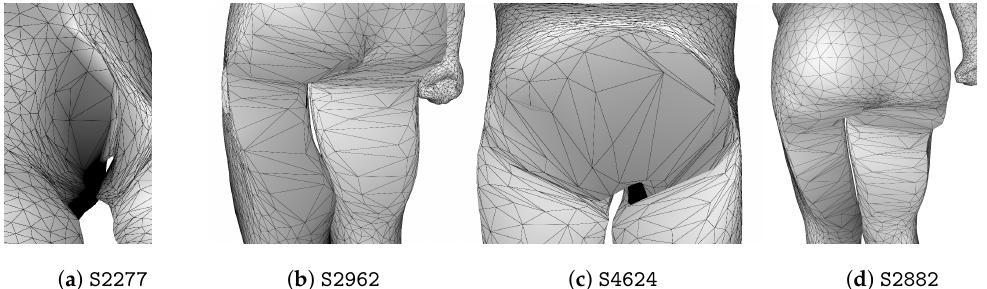
Figure 8. Anomalies of men scans detected by complete-linkage hierarchical clustering of persis- tence diagrams.